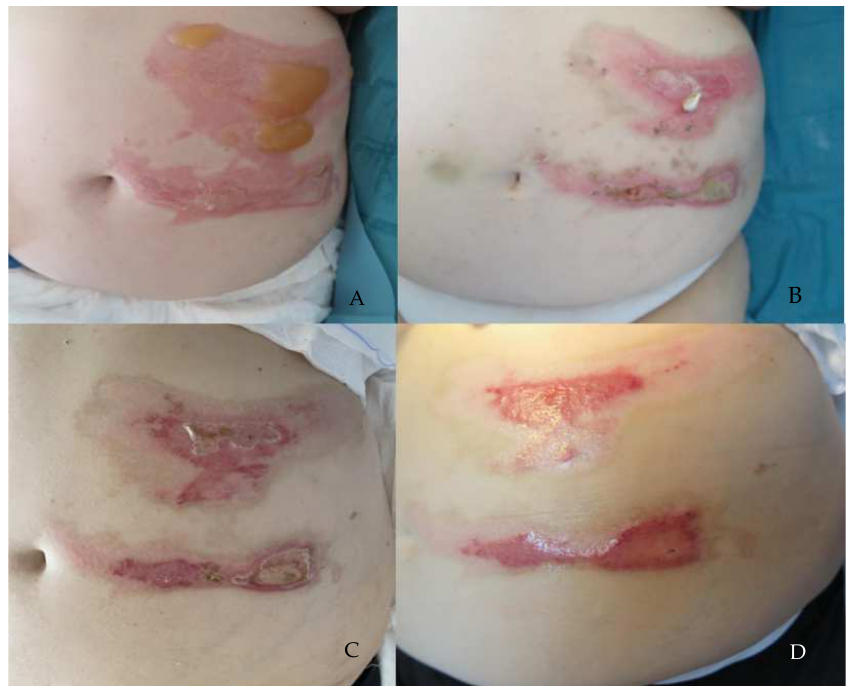
Figure 3. A 75-year-old female patient presented with a wound dehiscence localized on the medial aspect of the left leg. The patient was randomly assigned to the group treated with Connettivina ® Bio Plus cream and gauze. ( A ) Patient in V1. Wound bed is partially covered with fibrin, wound borders and perilesional skin are erythematous, and edema is observed. ( B ) Wound in V3, wound area sensibly reduced, wound bed exudate decreased considerably, although fibrin remained. Perilesional skin and wound borders improved overall. ( C ) Wound in V5. ( D ) V6, wound completely healed, and perilesional skin was a physiologic color.